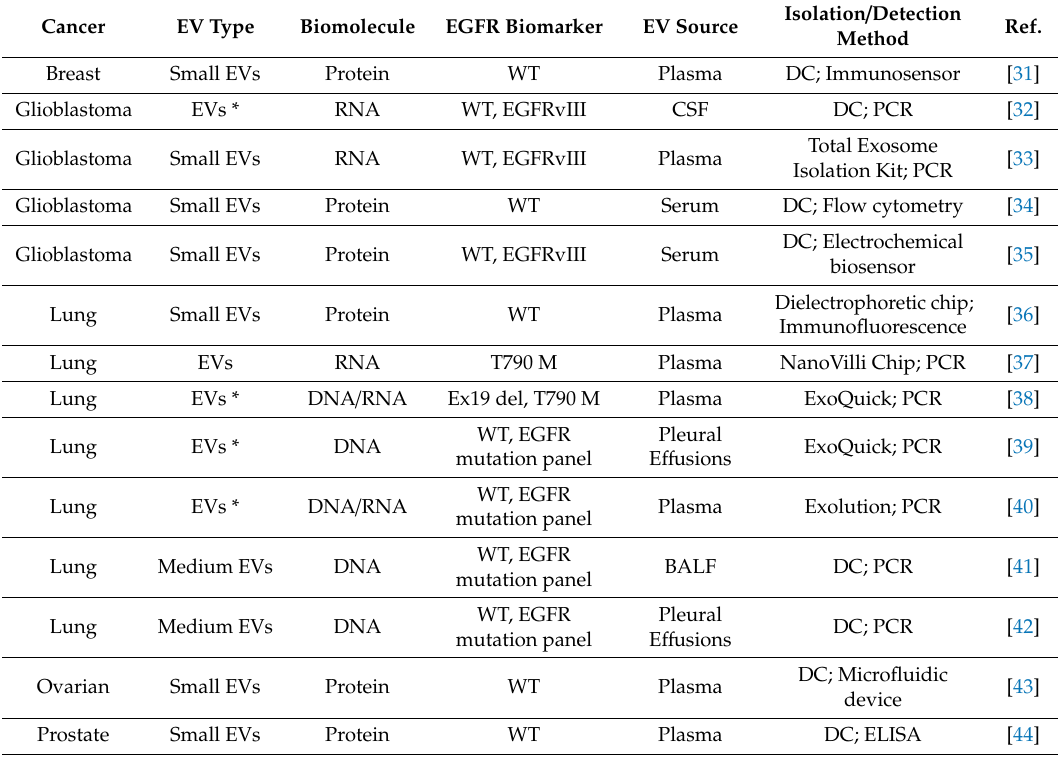
Table 1. Liquid biopsies and EV